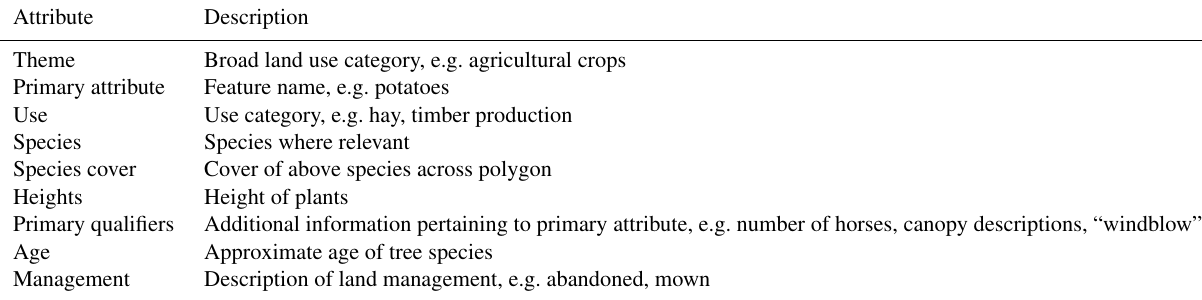
Table 3. Data collected regarding land cover and area features.